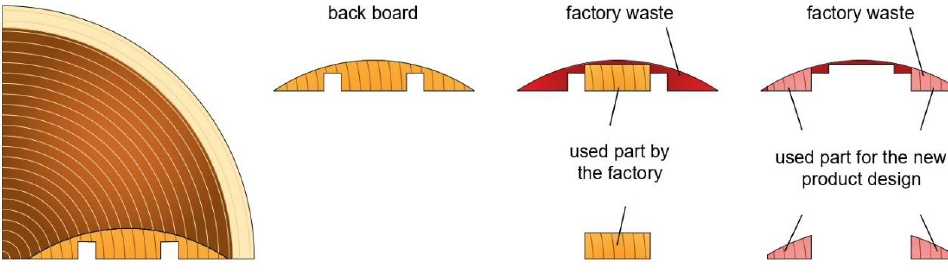
Figure 7. Back board factory residue (© Domagoj Mamić, 2022).